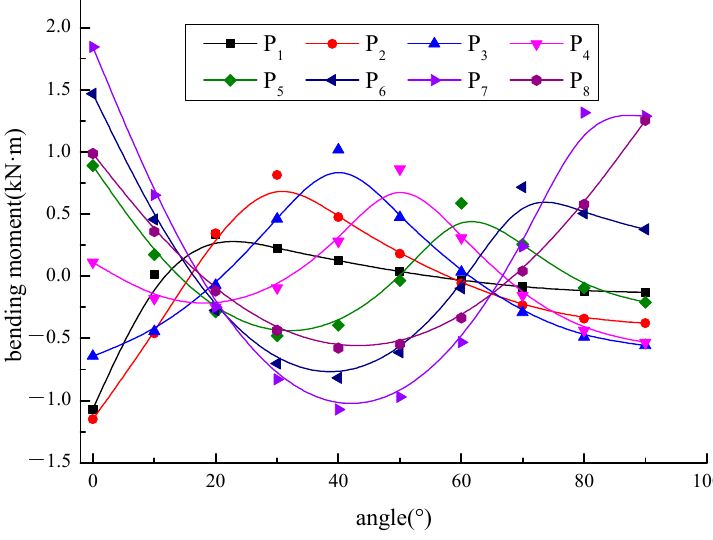
Figure 4. Bending moment distribution caused by unit adjustment load.